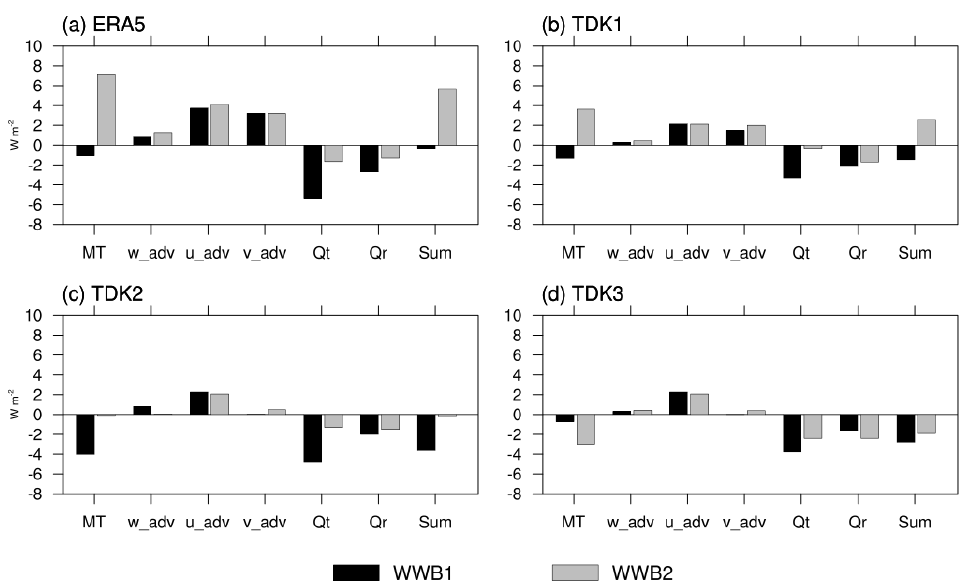
Figure 8. Fractional contributions of each MSE budget component to the east–west asymmetric MSE tendency pattern over the study domain (10 ◦ N–10 ◦ S, 105–120 ◦ E) for ( a ) ERA5, ( b ) TDK1, ( c ) TDK2, and ( d ) TDK3 experiment. Black boxes (gray boxes) are two-day averaged results when the WWB1 (WWB2) convective center is located near 90 ◦ E. The bars from left to right represent the MSE tendency (MT), the vertical MSE advection (w_adv), the zonal MSE advection (u_adv), the meridional MSE advection (v_adv), surface heat fluxes ( Qt ), the atmospheric radiative term ( Qr ), and the sum of MSE budget terms. The unit is W m − 2